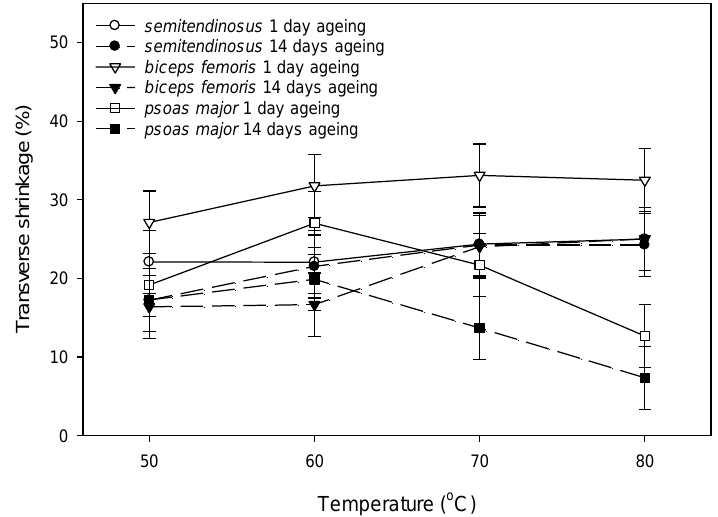
Figure 6. Effect of ageing (1 day post mortem vs. 14 days post mortem) and cooking temperature (50 ◦ C, 60 ◦ C, 70 ◦ C and 80 ◦ C) on transverse shrinkage of bovine semitendinosus , biceps femoris and psoas major . Cooking time was 30 min. after reaching the defined temperature (Tc + 30 min.). Values are least square means and vertical bars are least significant di ff erences (LSDs) for the three-way interaction muscle × ageing × temperature. There was no two-way interactive e ff ect of ageing × temperature nor three-way interaction of muscle × ageing × temperature ( p > 0.05). Main e ff ects were as follows: p (muscle) < 0.001, p (ageing) = 0.159, p (temperature) = 0.008. Significant interactions were as follows: muscle × temperature p < 0.001, and muscle × ageing p < 0.001.